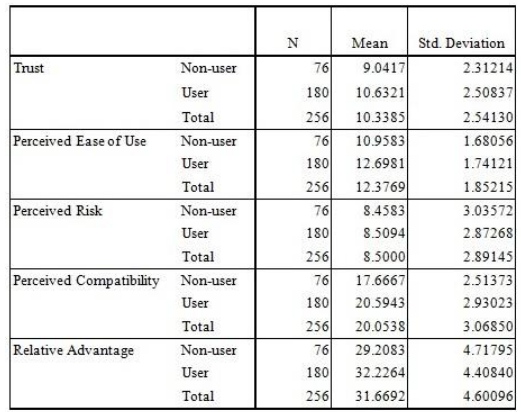
Table 5: Descriptive